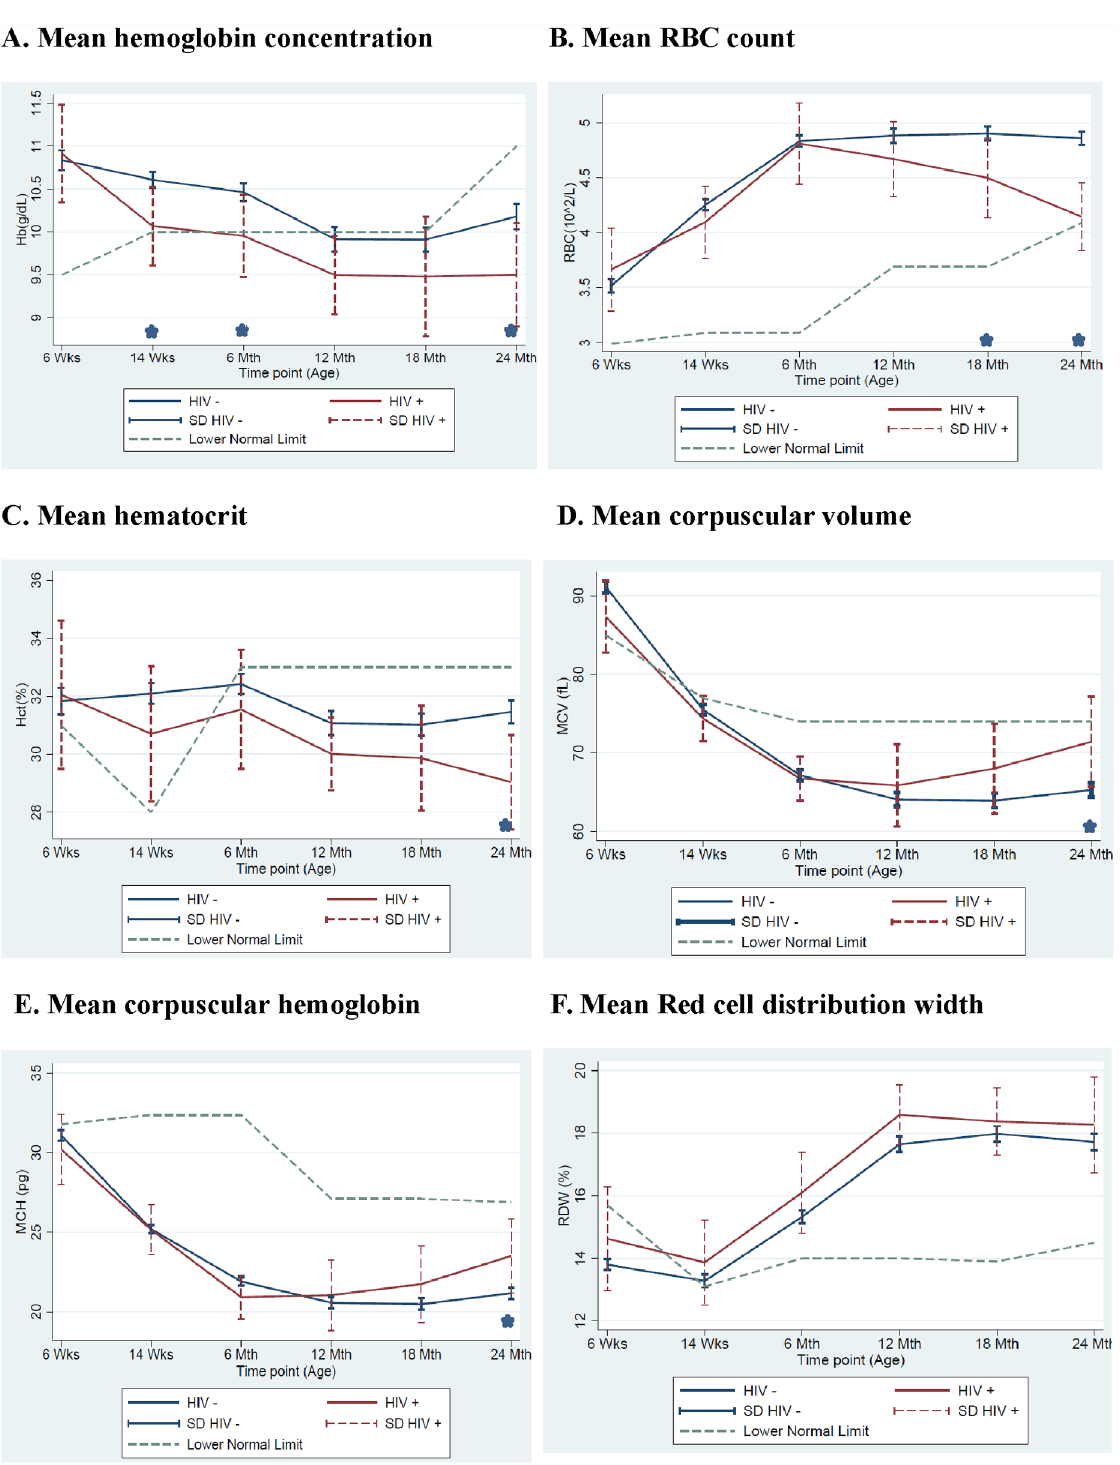
Fig 1. Comparison of mean A) hemoglobin concentration, B) RBC count, C) hematocrit, D) corpuscular volume, E) corpuscular hemoglobin and F) red cell distribution width by HIV-1 status in children, Kisumu Breastfeeding Study, Kisumu, Kenya, July 2003- February 2009. Dotted line represents the lower limit of normal for each parameter. ( * p < 0.05 between HIV-infected and HIV-uninfected children).